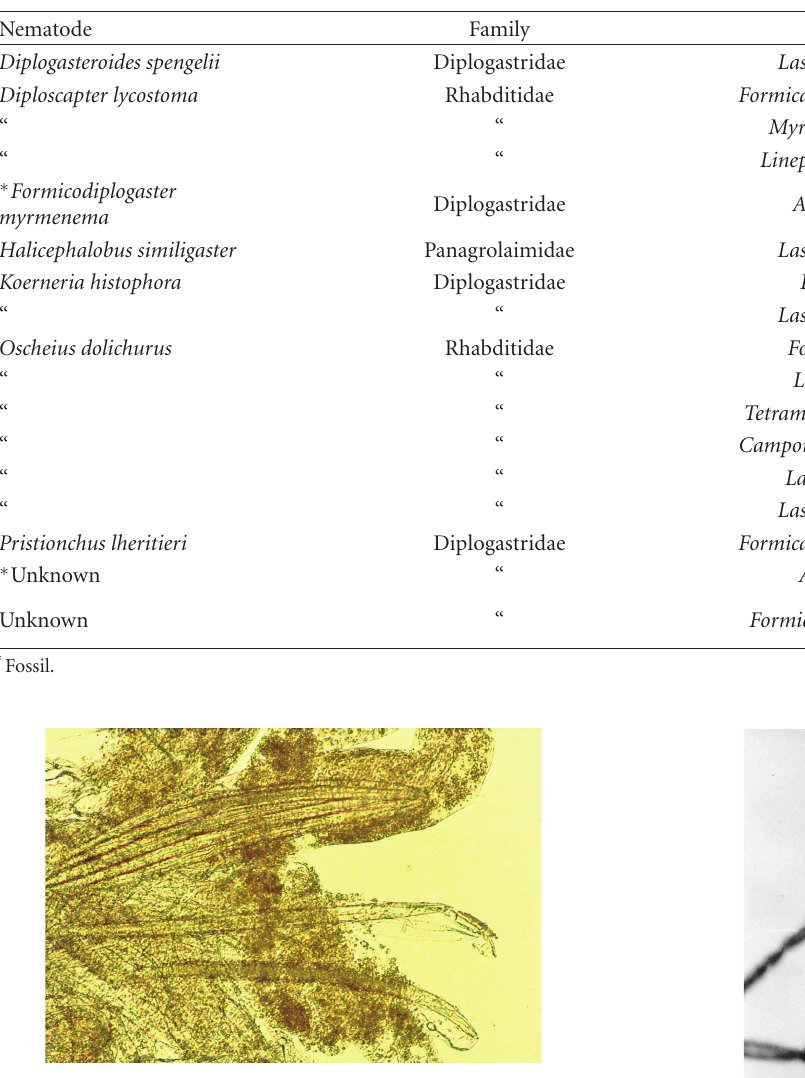
Figure 22: Dauer juveniles of a diplogastrid in the postpharyngeal glands of Formica obscuriventris clivia from Oregon.